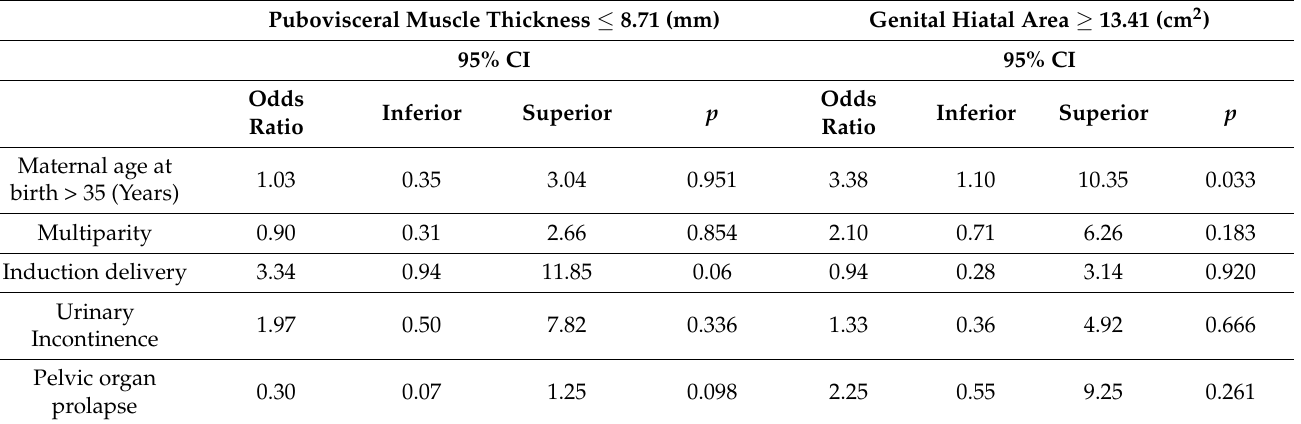
Table 2. Correlation between variables representative of the study population and the cutoff measure for pubovisceral muscle thickness and genital hiatus area.